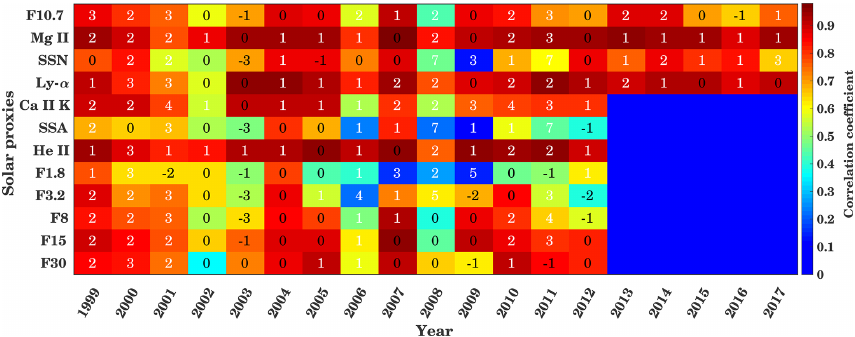
Figure A3. Cross-correlation and time delay between GTEC and different solar proxies for the years 1999 to 2017 at the timescale of 32 to 64d. Background colors show the maximum correlation coefficients, and the inserted numbers show the delay in days corresponding to maximum correlation.